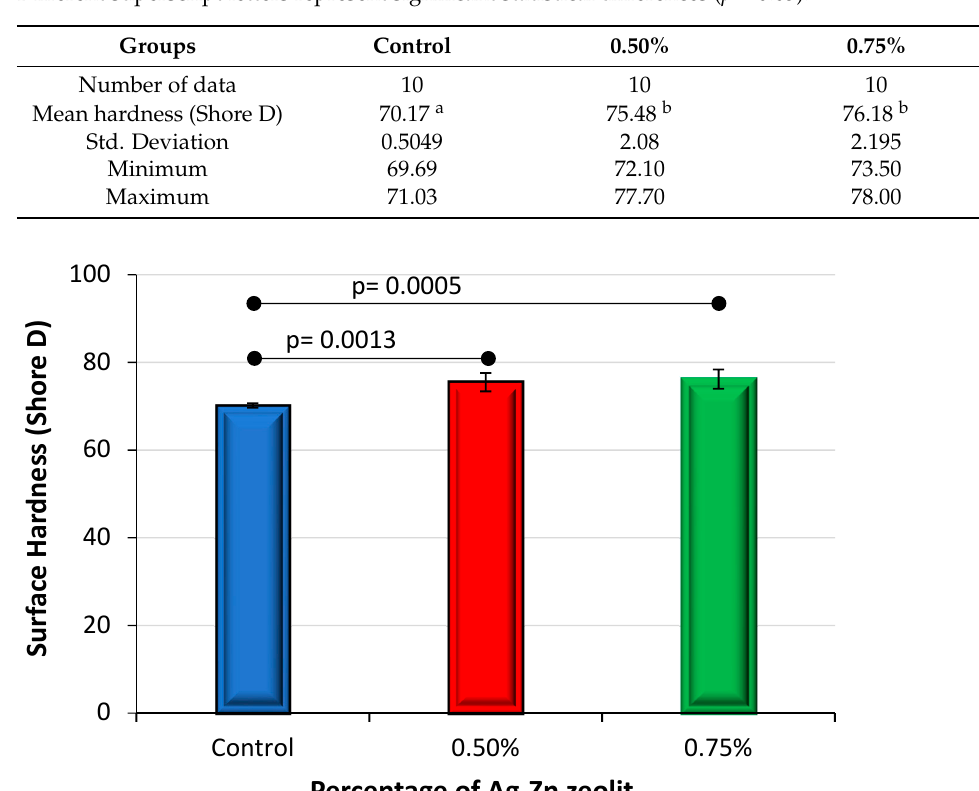
Figure 9. Bar chart showing mean values of surface hardness in the CC acrylic resin incorporated with Ag-Zn zeolite at different concentrations (0.50 wt.% and 0.75 wt.%) and without any Ag-Zn zeolite (control group). Horizontal lines connecting two bars show statistical significance ( p < 0.05).